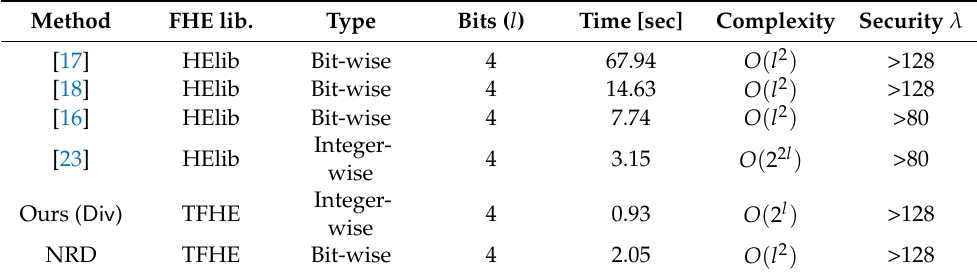
Table 2. Results: comparison with existing homomorphic division implementations. We abbrevi- ate the non-restoring division method as NRD. The “Complexity” column shows the asymptotic complexity for a one-bit-length integer input.